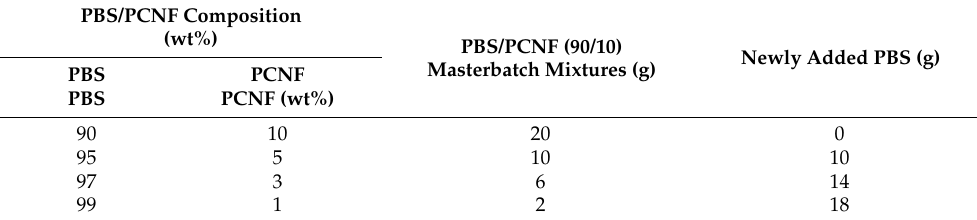
Table 1. PBS/PCNF composition.